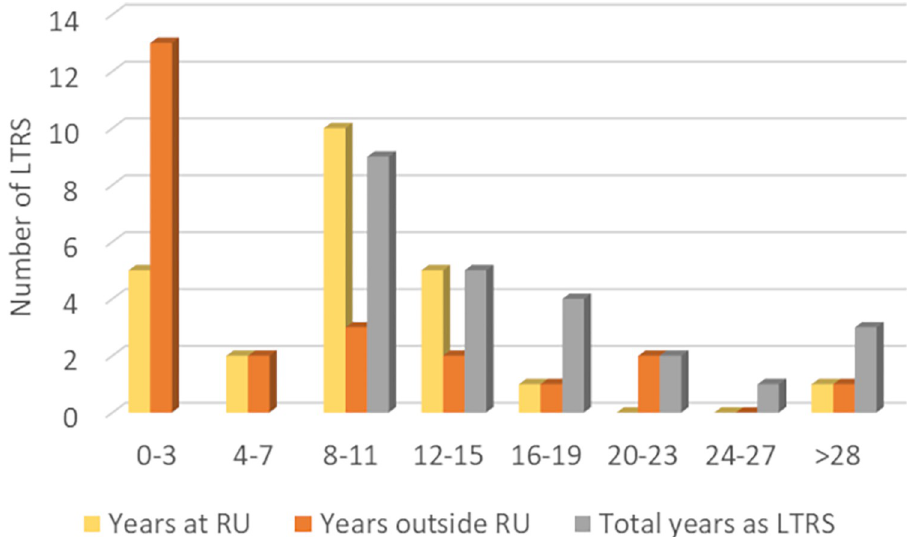
Fig 2. Number of years the study participants worked outside and at the research university (RU) where this study was conducted and total number of years as a long–term research staff. Note that the grey bars add up to the number of participants (24), but that the yellow and orange bars do not because some participants have worked both outside and at the RU.